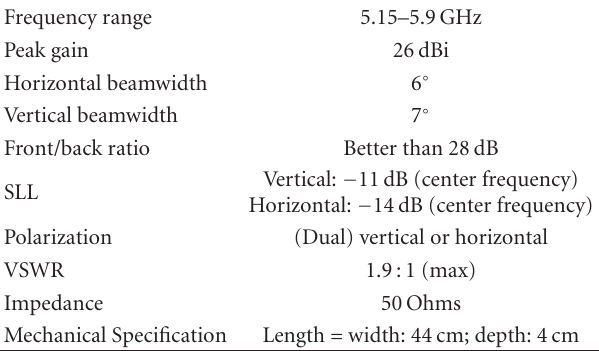
Table 1: Wideband dual-polarized patch antenna